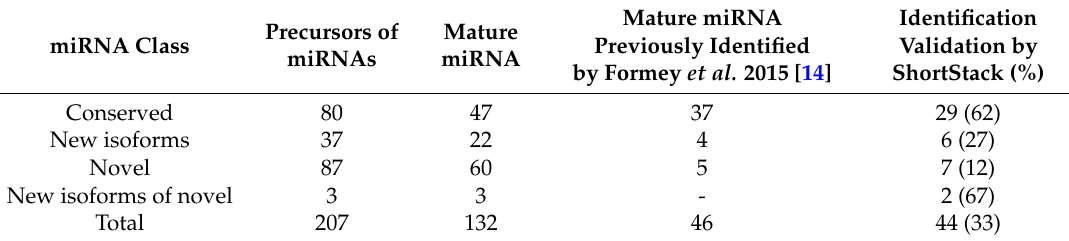
Table 2. Statistics of the identified precursors and their corresponding mature miRNAs.